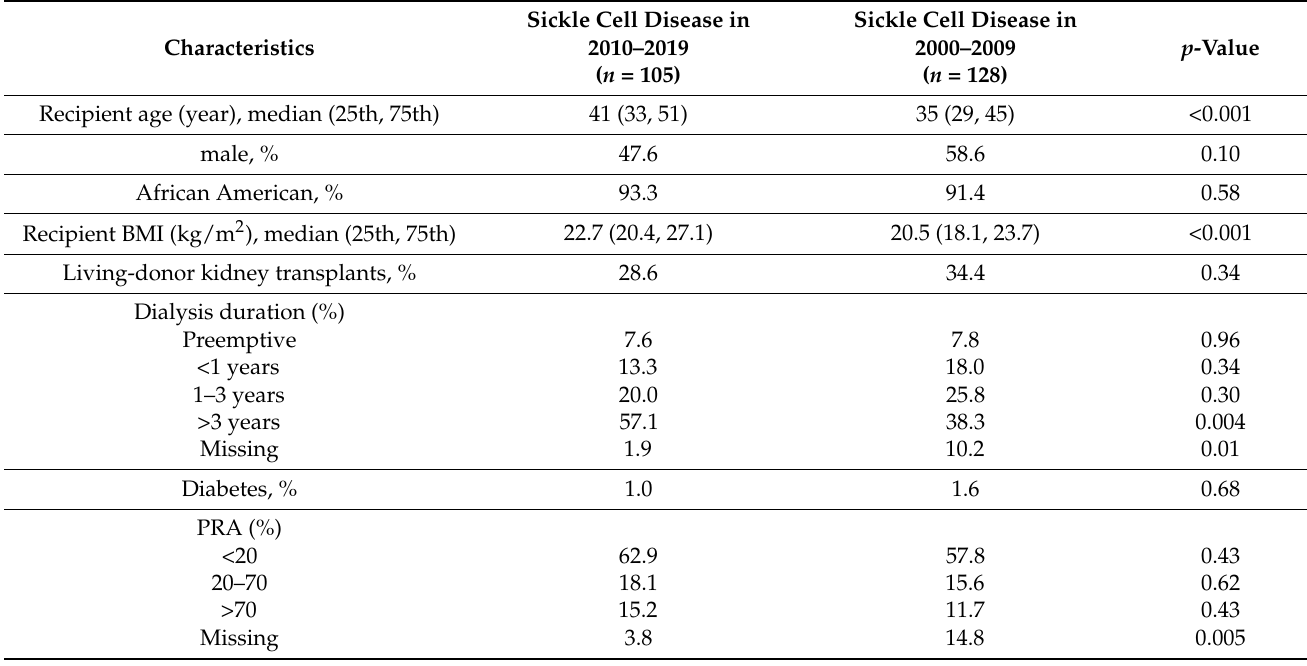
Table 3. Clinical characteristics between sickle cell disease in 2010–2019 and 2000–2009.